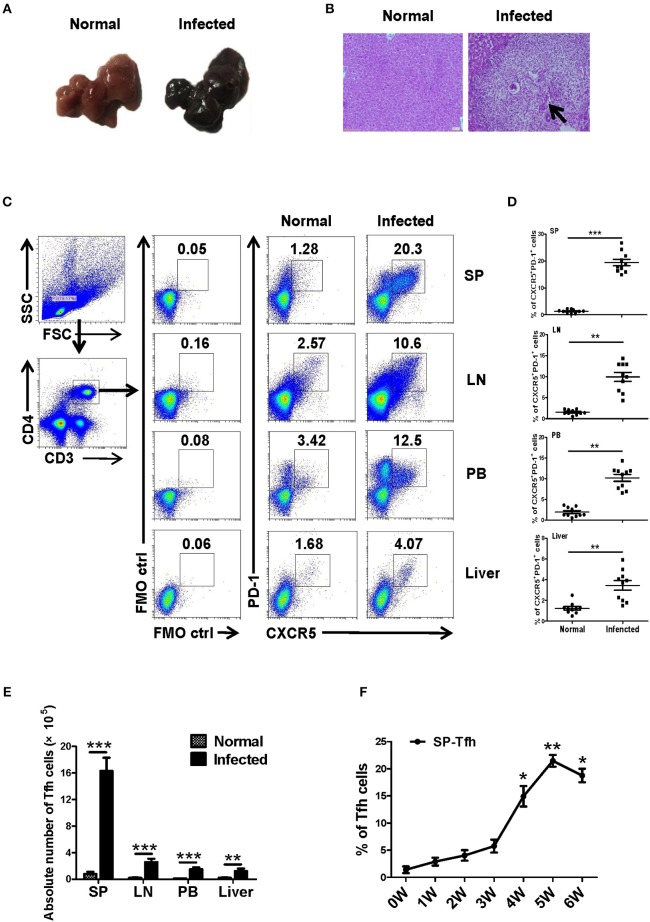
S. japonicum-infection induce Tfh cells in vivo. (A–D) C57BL/6 mice were infected percutaneously with 40 ± 5 cercariae and sacrificed at 5–6 weeks after infection, and different tissues were harvested. (A) Representative images of livers. (B) Representative images of liver H&E staining; arrows indicate granuloma. The percentage (C,D) and absolute numbers (E) of CD4+CXCR5+PD1+ cells in the lymphocytes isolated from spleen (SP), lymph node (LN), peripheral blood (PB), and live of both normal and infected mice were evaluated by flow cytometry after staining with specific antibodies. Each group included 10 mice. (F) Spleens from infected mice were harvested; the dynamic proportions of CD4+CXCR5+PD-1+ Tfh cells in the S. japonicum infected mice was evaluated by flow cytometry. Data are shown as mean ± SEM of six samples in each group from one representative experiment, and repeat three times with similar results. *P < 0.05, **P < 0.01, ***P < 0.001 compared with the corresponding controls (0W), One-way ANOVA was used.